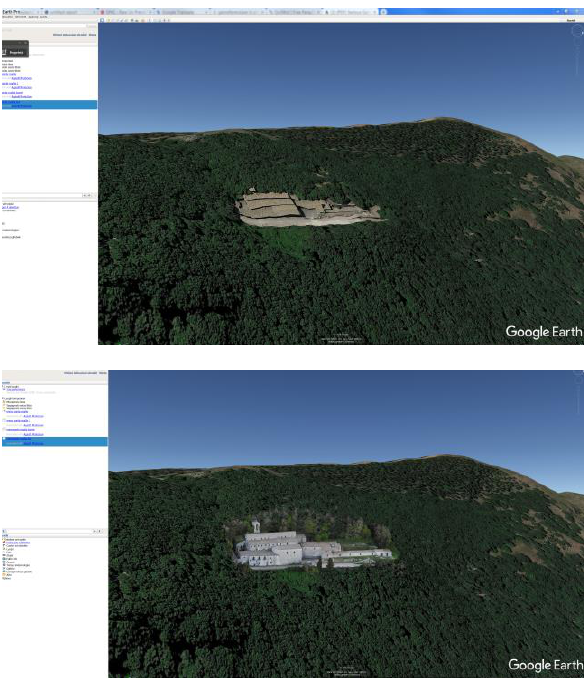
Figure 6. The model in the Blender environment Subsequently, the model was imported to SketchUp. Then it was aligned with the coordinate system applicable for the GE platform as shown in figure 7.